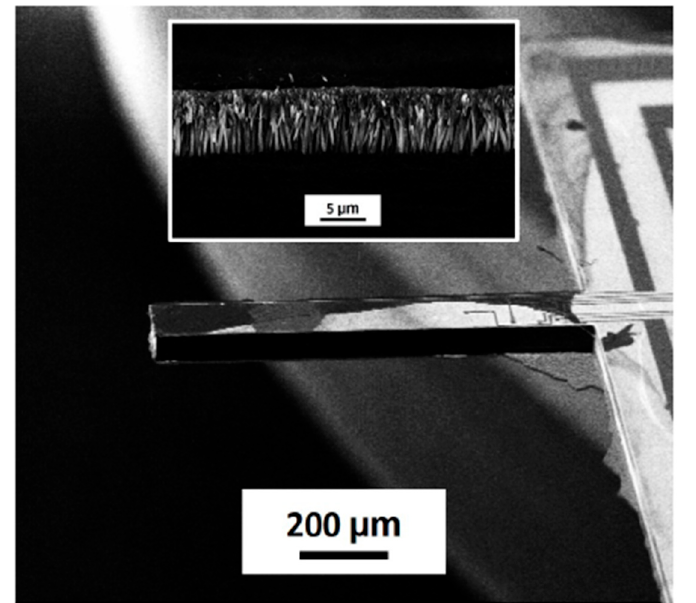
Figure 6. Inclined-view SEM graph of a Si microcantilever with ZnO NRs grown on its back surface